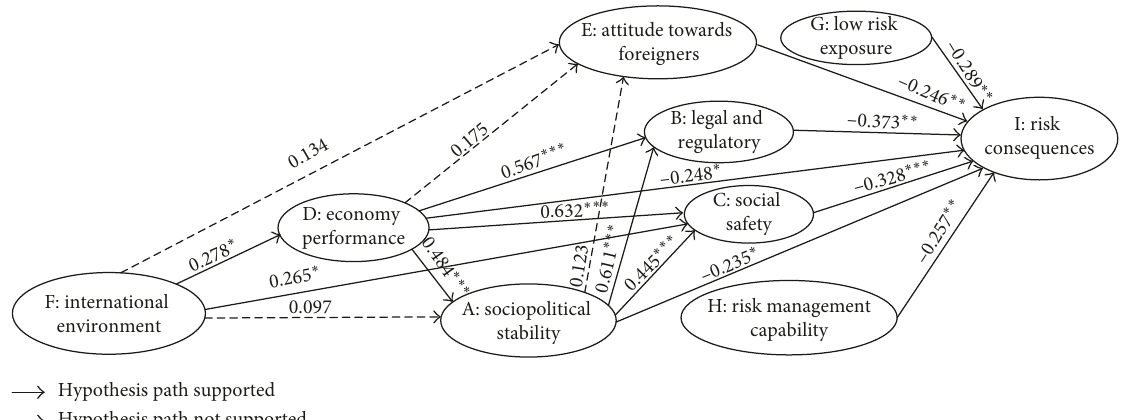
Figure 2: Networking of political risk paths. ∗ Significance at the p � 0 . 10 level, ∗∗ significance at the p � 0 . 10 level, and ∗∗∗ significance at the p � 0 . 10